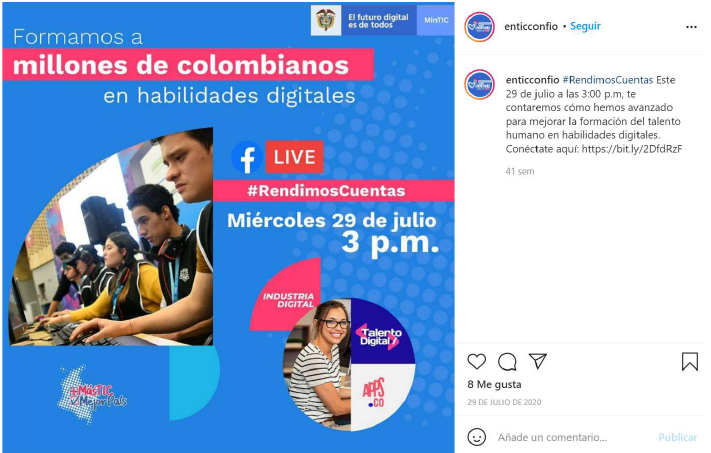
Figure 10. Example of a publication for educational purposes. This image shows the channel @enticconfio sharing with the community the date and online site for a free training session. Source: @enticconfio.